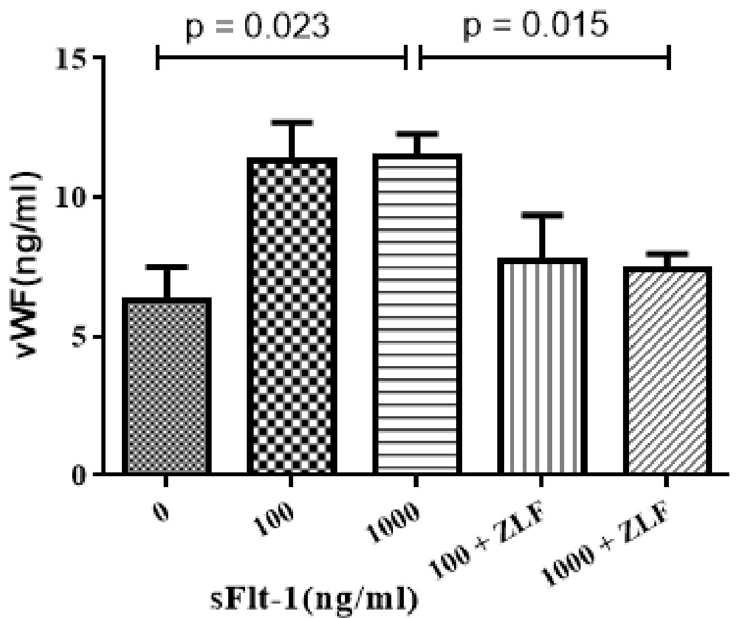
Fig 3. Effects of sFlt-1 and Z-LEHD-FMK on the vascular injury marker of vWF. The HUVECs were treated with the indicated concentrations of sFlt-1, and then treated with or without Z-LEHD-FMK. The histogram showed that vWF expression were significantly upregulated by sFlt-1 stimulation at 1000 ng/ml (11.50 ± 1.39 vs. 6.31 ± 2.07 ng/ml, p = 0.023) compared with those of untreated cells, whereas the expression of vWF was down-regulated after added with Z-LEHD-FMK (11.50 ± 1.39 vs. 7.39 ± 1.78 ng/ml, p = 0.015). Results are the means ± standard deviation of three independent experiments.